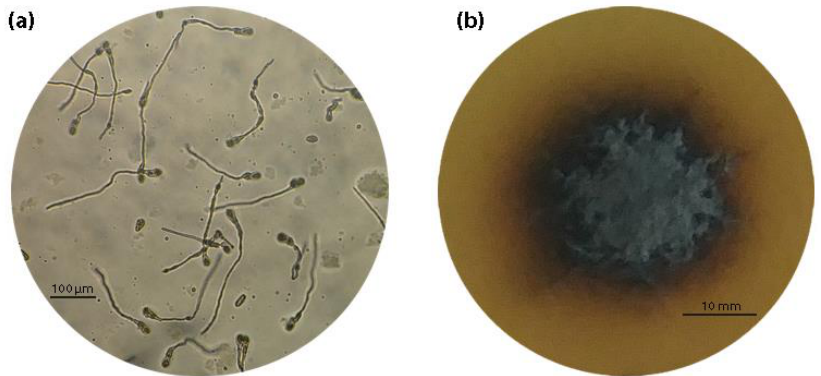
Figure 1. The development of different V. inaequalis growth stages on control plates with MEA: ( a ) germ tube elongation at 36 hours after inoculation with aqueous spore suspension containing 10 4 spores per mL; and ( b ) mycelial growth at 21 days after inoculation with a 4 mm mycelial disc. The images were taken with Nikon Eclipse Ei upright microscope (Nikon Europe BV, Amstelveen, The Netherlands) using 10 × ( a ) and 4 × ( b ) plan achromat objective lens.